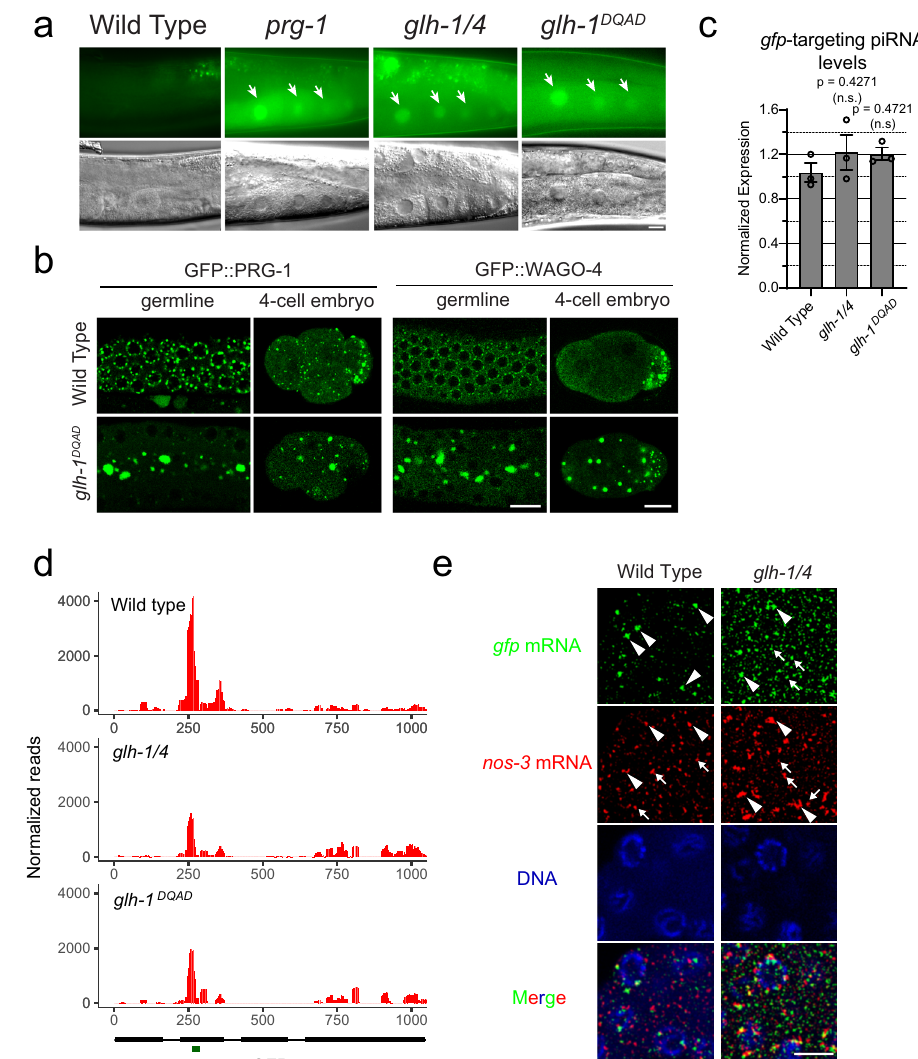
Fig. 2 | GLH/VASA helicases are required for piRNA-dependent silencing of a piRNA reporter. a GFP expression of the piRNA reporter in the indicated strains. Arrows indicate the adult germline nuclei in maturing oocytes with expression of GFP transgenes (top). DIC images of the corresponding reporter images (bottom). Bar, 10micrometers. b Fluorescent micrographs show the localization of PRG-1 and WAGO-4 in the indicated strains in the adult germline (left) and in the four-cell embryo(right).Bar,10micrometers. c q-RTPCRmeasurementsoftheabundanceof the GFP-targeting piRNA in the indicated strains. Statistical analysis was performed using a two-tailed Student ’ s t test. Bars indicate the mean, errors bars indicate the standarddeviation,anddatapointsindicatevaluesforthethreetechnicalreplicates